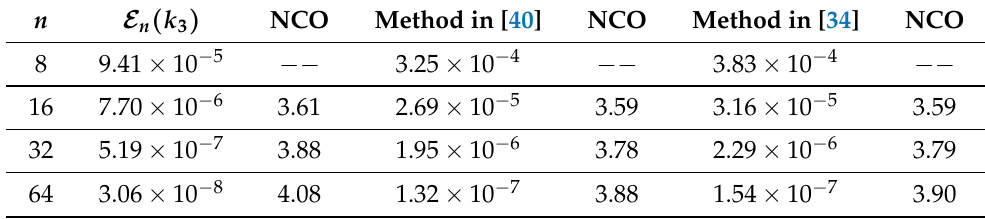
Table 7. Estimated errors for function k 4 , and NCOs with different values of n